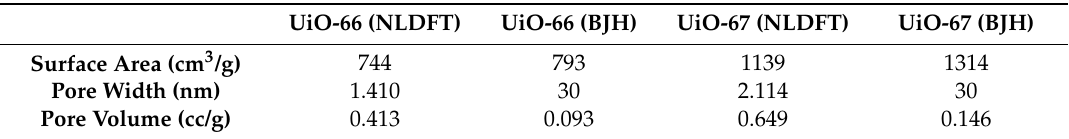
Table 3. The degree of porosity evaluated using non-local density function theory (NLDFT) and Barrett, Joyner, and Halenda (BJH) analysis.